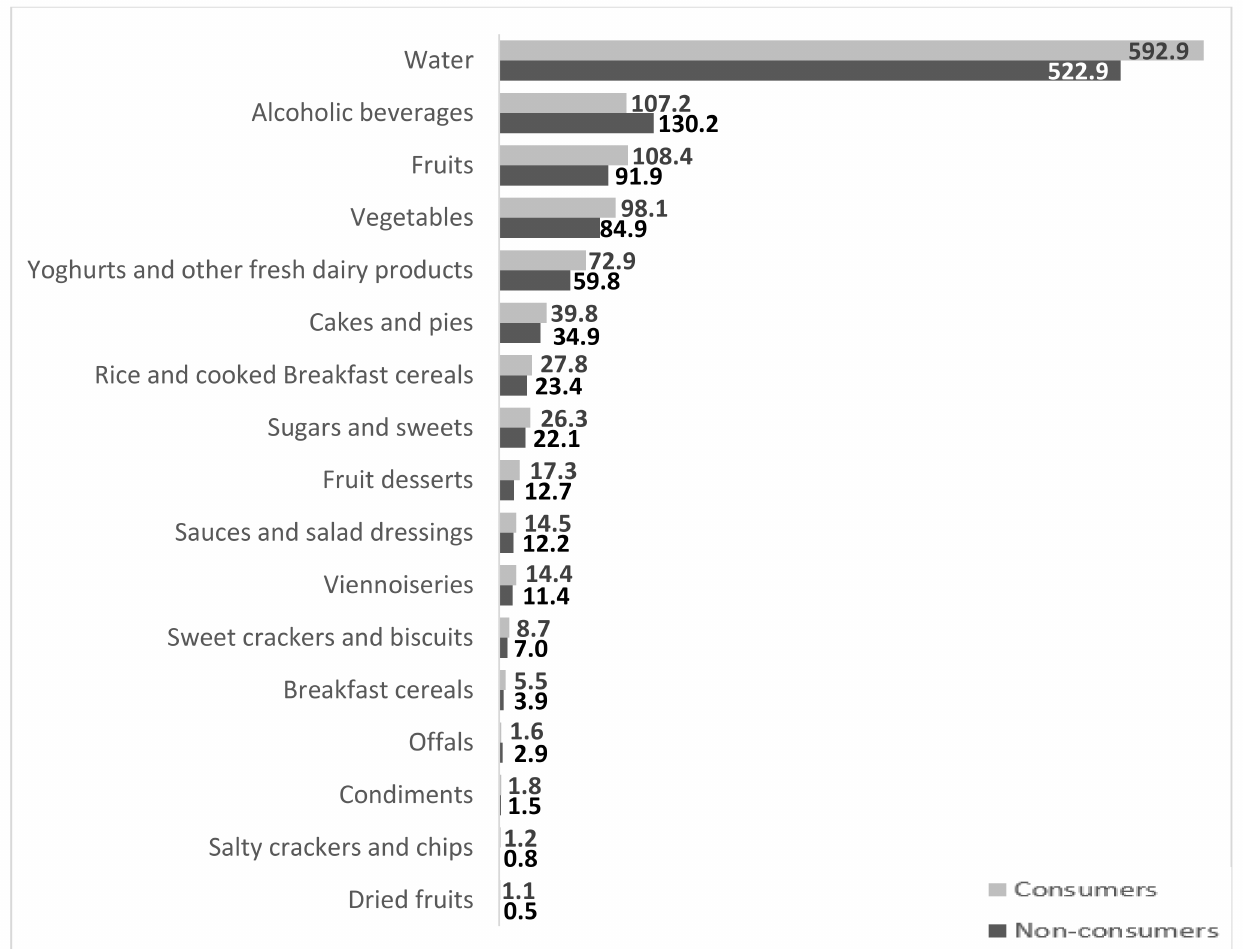
Figure 1. Significant differences ( p < 0.05) in daily intake (g/day) of various food groups in consumers (light bars) versus non-consumers (dark bars) of FJ. A total of 37 mutually exclusive food groups were compared using a Student’s t